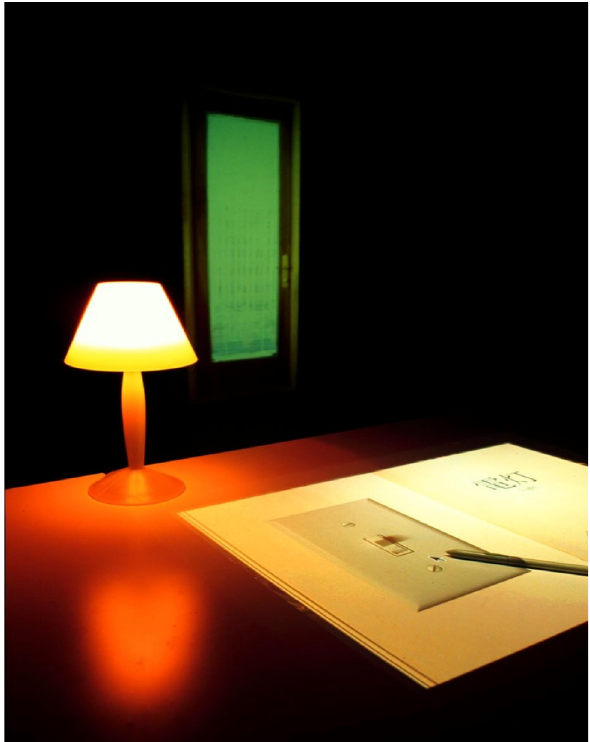
Figure 2 | Masaki Fujihata , Beyond Pages , 1995, Courtesy of the